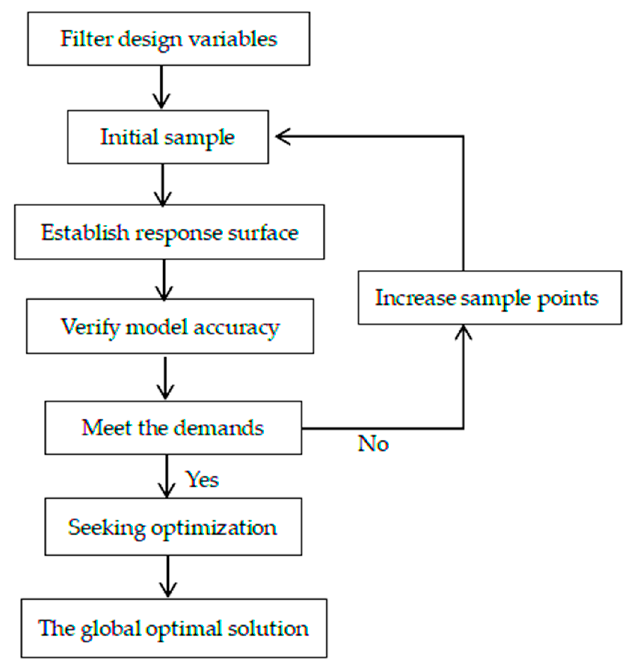
Figure 9. Flow chart of optimization design.